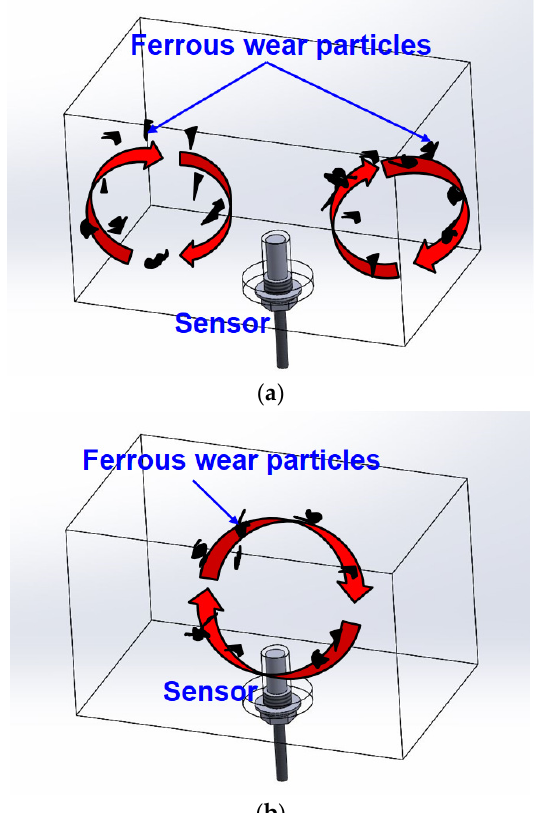
Figure 13. Relationship between flow and sensor position: ( a ) Case where it is difficult to detect wear particles; ( b ) Case where it is easy to detect wear particles.